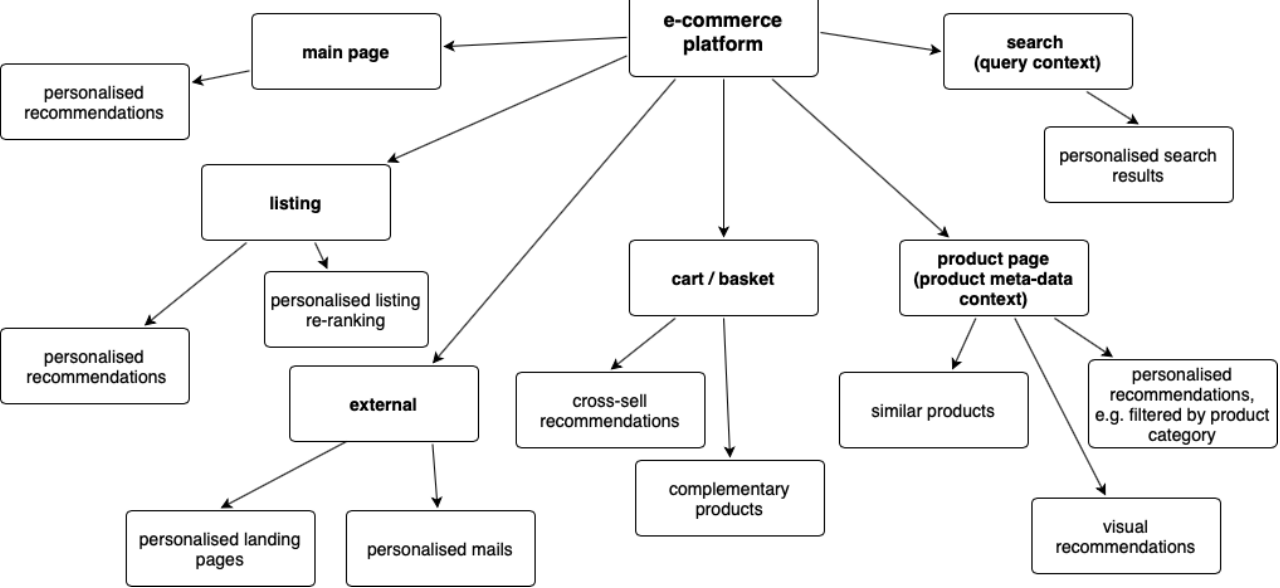
Figure 1. Diagram of different recommendation scenarios depending on the site within an e- commerce